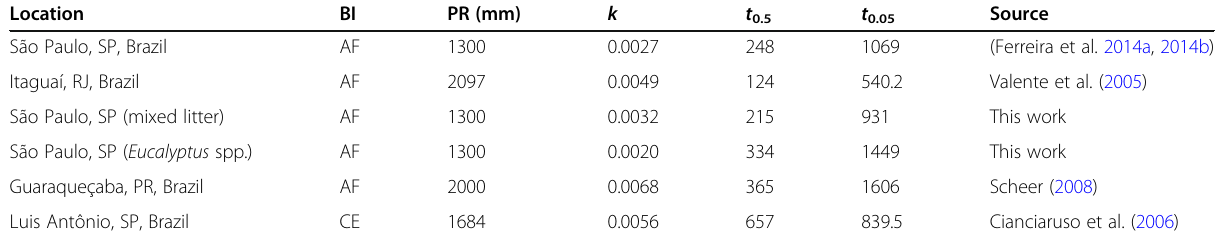
Table 3 Decomposition constant ( k ) and time required for decomposition of 50% and 95% of litter in studies conducted in the Atlantic Forest and Cerrado biomes. t 0.5 and t 0.05 time required to decompose 50% and 95% of the litter, respectively; BI biome ( AF Atlantic Forest, CE Cerrado); PR precipitation